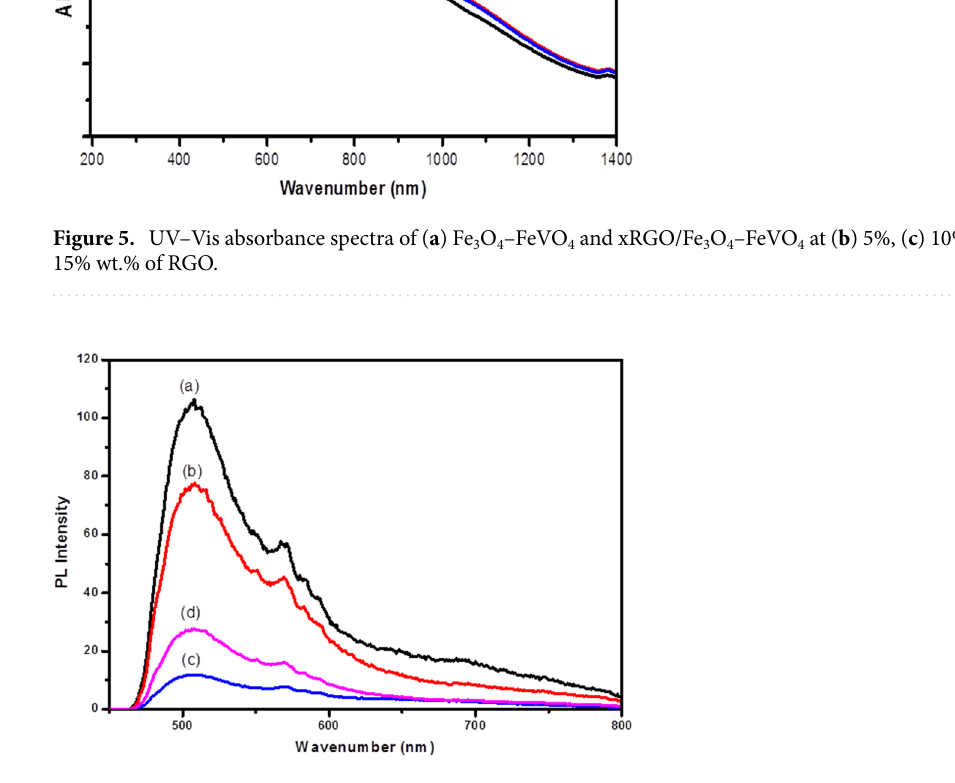
Figure 6. PL spectra of ( a ) Fe 3 O 4 –FeVO 4 and xRGO/Fe 3 O 4 –FeVO 4 at ( b ) 5%, ( c ) 10%, ( d ) 15% wt.% of